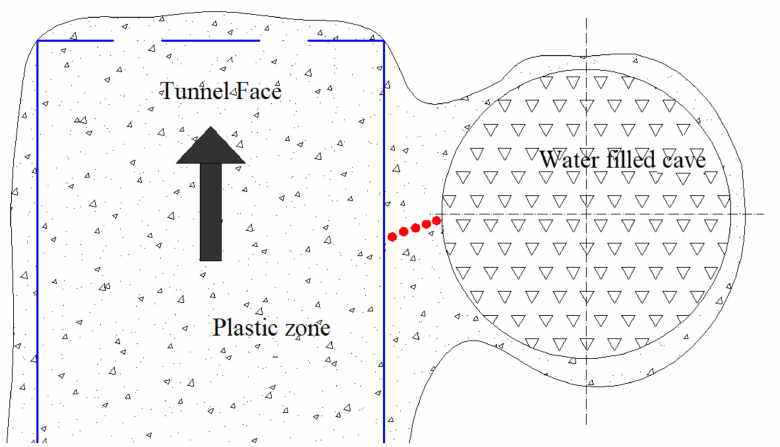
Figure 9. Layout of the monitoring